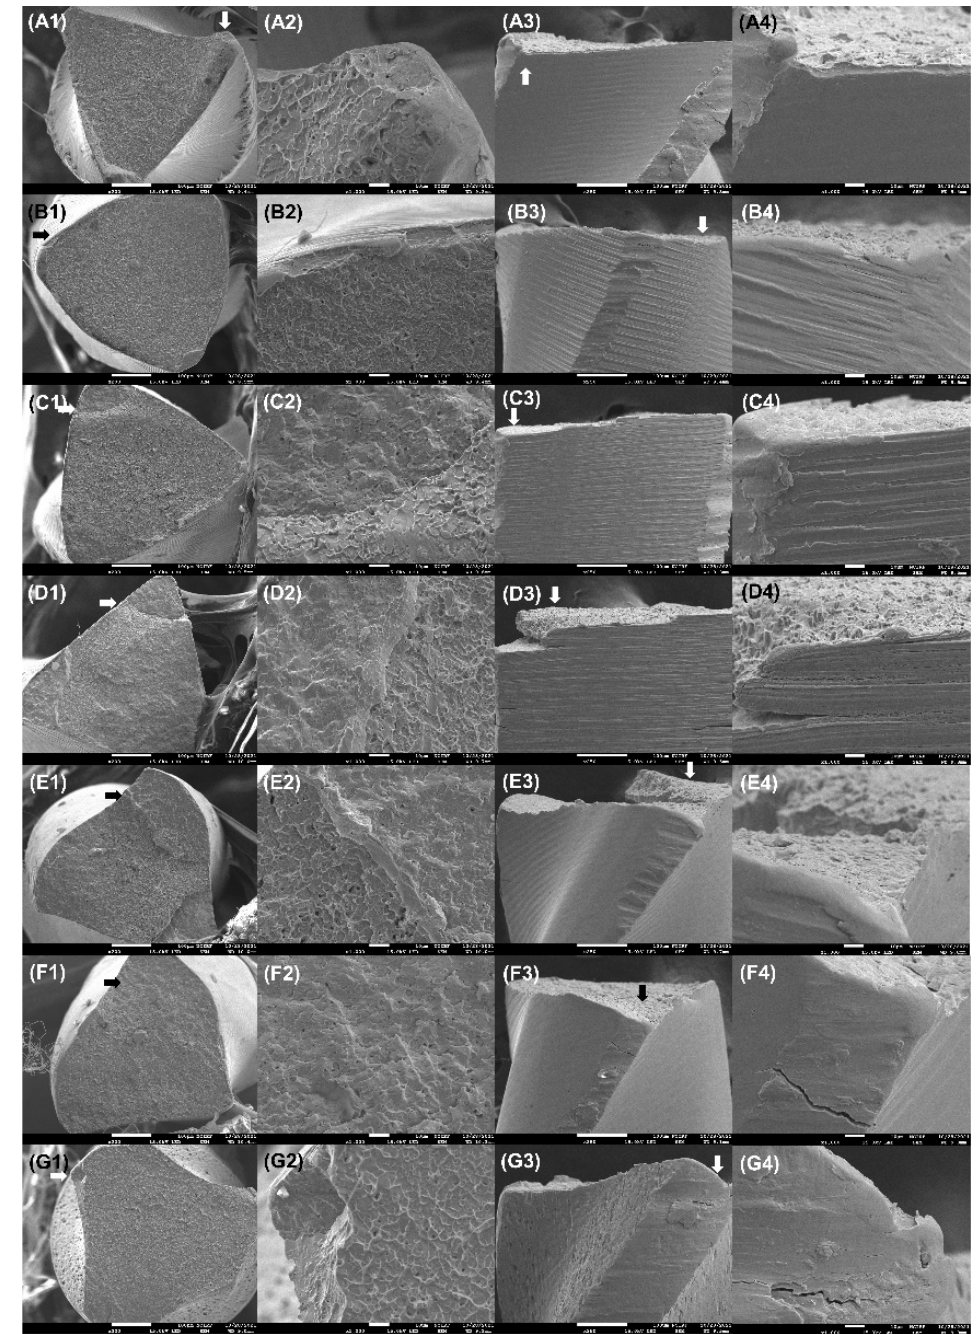
Figure 4. SEM images after cyclic fatigue resistance testing of ( A ) ProFile, ( B ) ProTaper Gold, ( C ) ProfaTaper Gold, ( D ) HyFlex CM, ( E ) V Taper 2H, ( F ) 2Shape, and ( G ) K3XF. ( A1 – G1 ) Fractured surfaces (×200); ( A2 – G2 ) magnified (×1000) images of the fractured surfaces at the arrow regions in ( A1 – G1 ), showing fatigue striations; ( A3 – G3 ) lateral surfaces (×250); ( A4 – G4 ) magnified (×1000) views of fractured surfaces at the arrow regions in ( A3 – G3 ), showing cracks. The fractured surfaces after the torsional resistance tests exhibit multiple circular abrasion marks at the center of the cross-section (Figure 5(A2–G2). The lateral surfaces of the fractured NiTi files display ductile fractures with plastic deformation (Figure